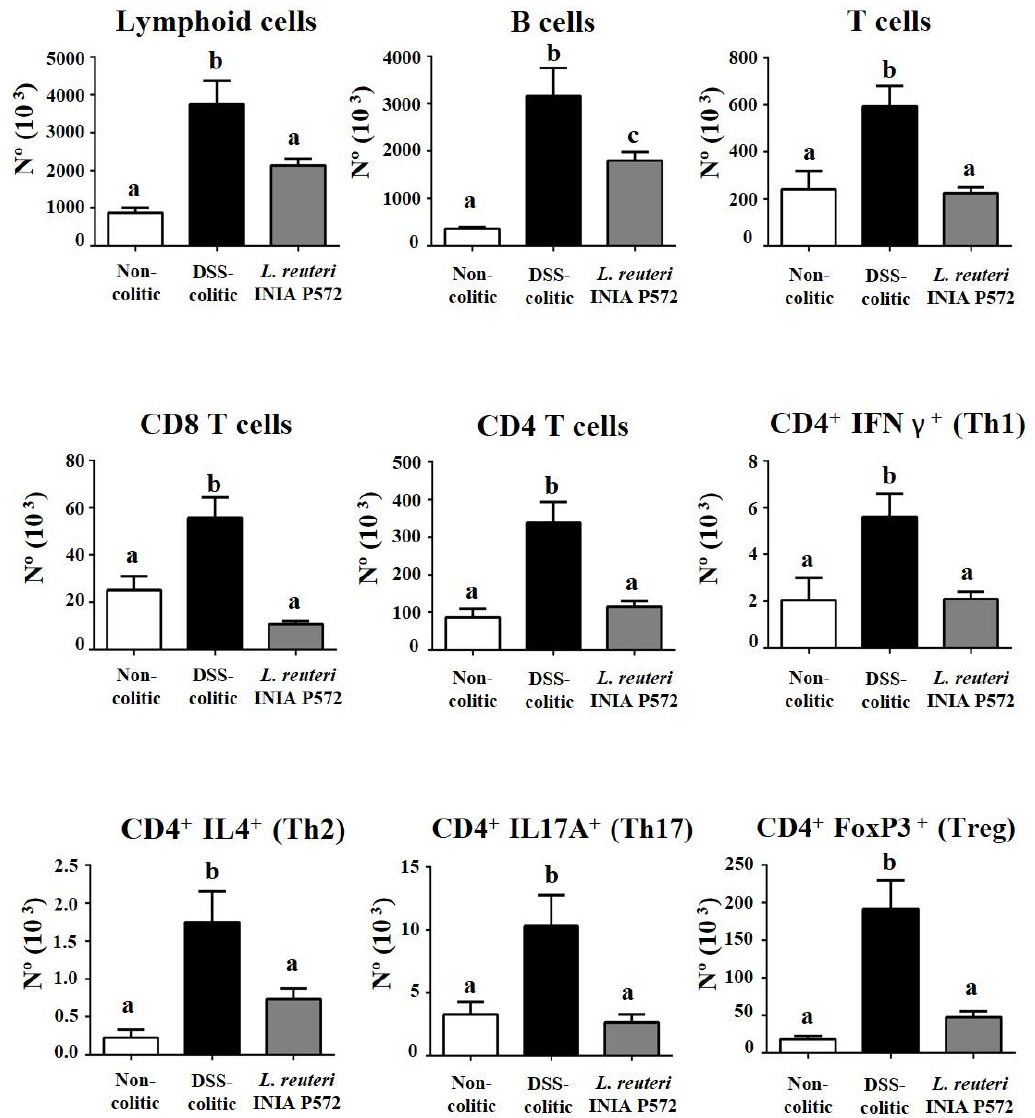
Figure 7. Evaluation of the impact of L. reuteri INIA P572 on the immune response in DSS-colitic mice. Analysis of the indicated immune cell population in the colonic lamina propria of the different experimental groups. Absolute cell number (N ◦ ) of lymphoid cells, B cells (B220+), T cells, cytotoxic T cells (CD8+), CD4 T cells, Th1 cells (CD4+ IFN γ +), Th2 cells (CD4+ IL4+), Th17 (CD4+ IL17+), and Tregs (CD4+ FoxP3+). Data are expressed as mean ± SEM ( n = 10). a,b,c Groups with different letters statistically differ ( p < 0.05).